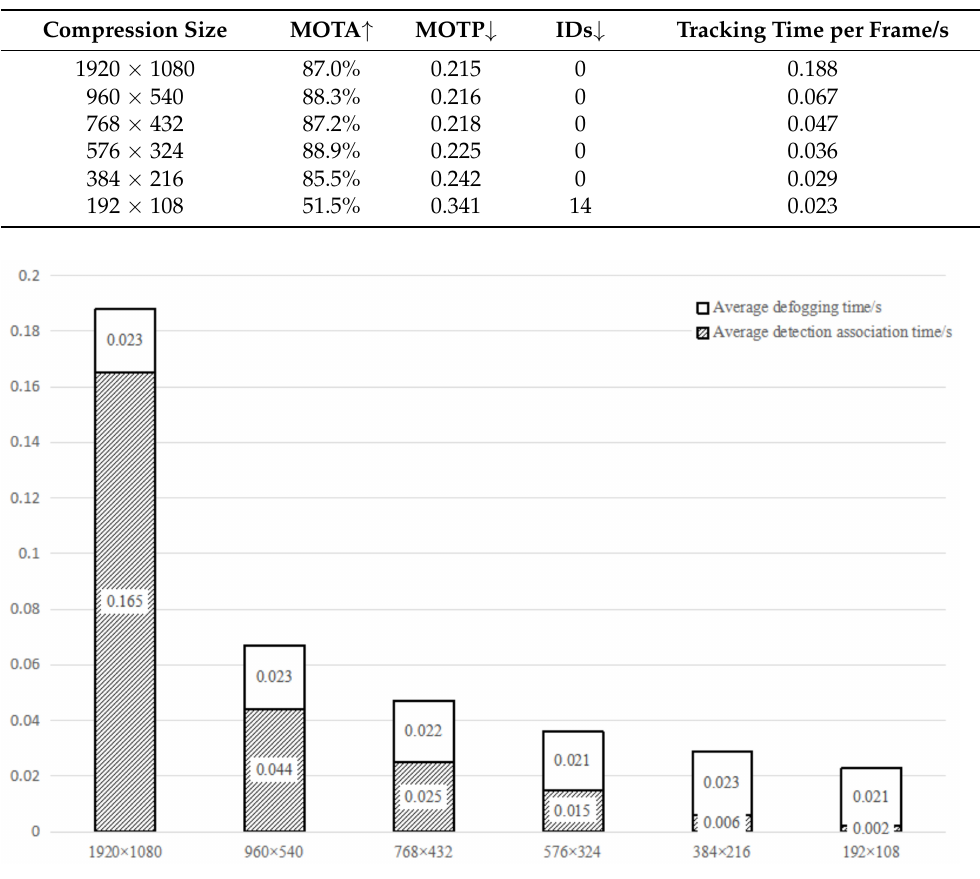
Table 6. Indexes for evaluating the tracking effect with different compression sizes.